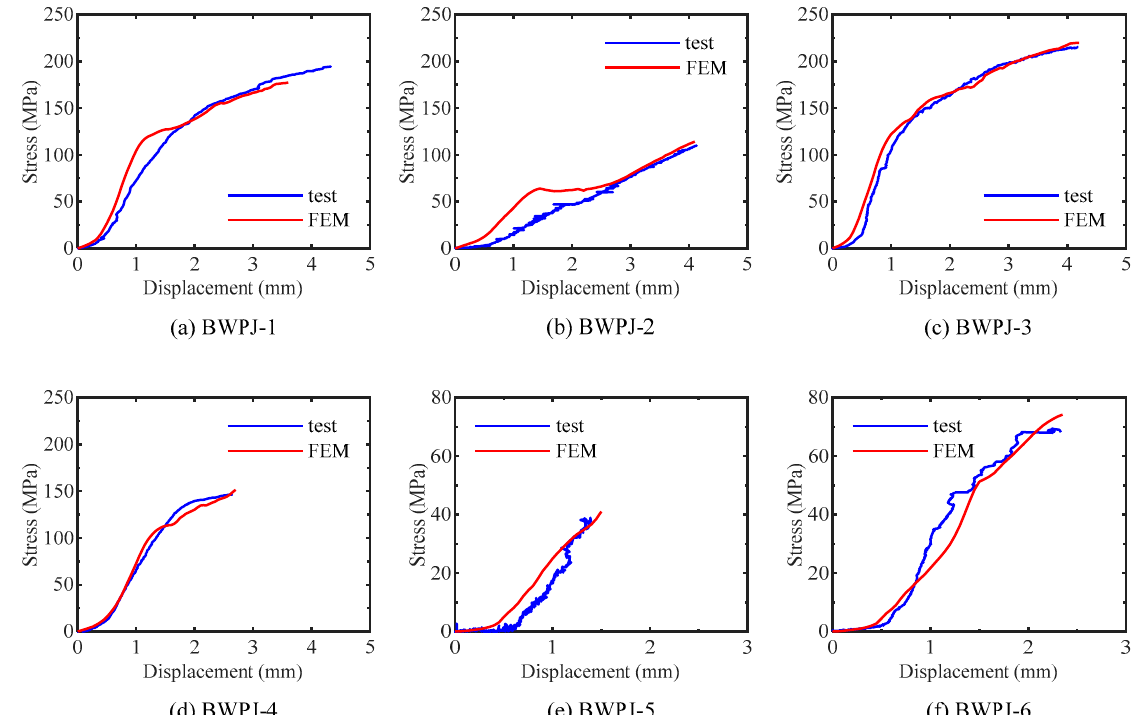
Figure 12. Stress development curves of the stirrups.